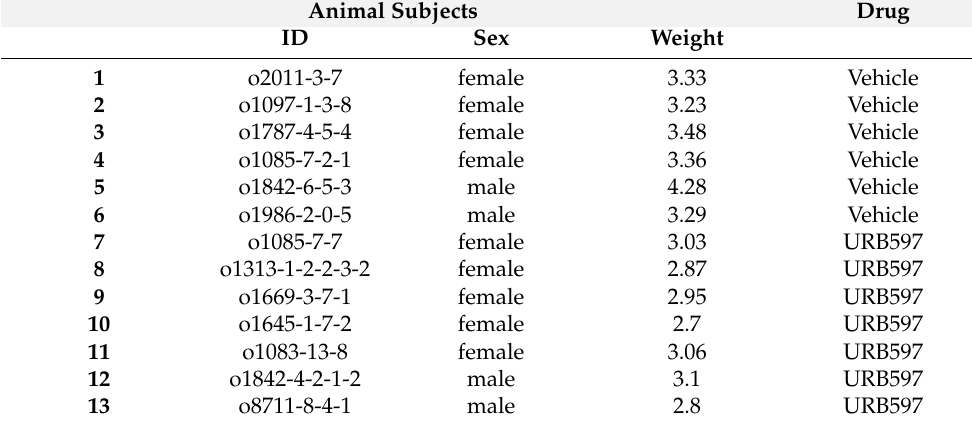
Table 1. Characteristics of the monkeys used in this